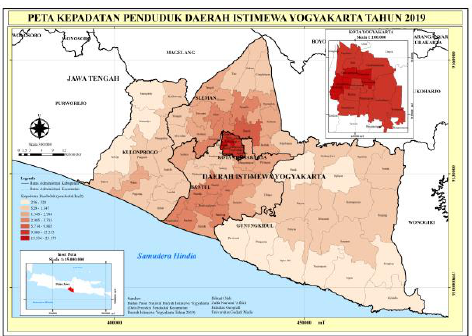
Figure 2 Choropleth Map Using the Most Effective